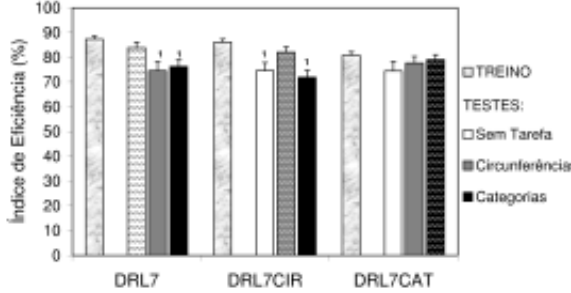
Figura 3. Média ( ± EP) dos Índices de Eficiência (%) nas sessões da terceira fase de treino e testes dos grupos DRL7 ( N =14), DRL7CIR ( N =14)